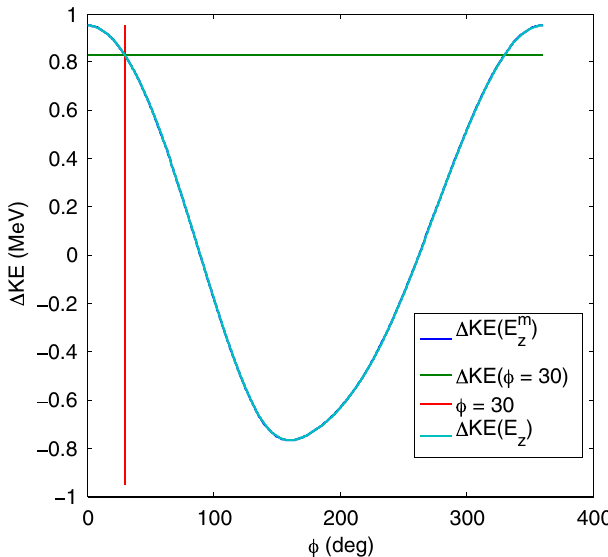
FIG. 5. Checking the energy gain approximation scheme.